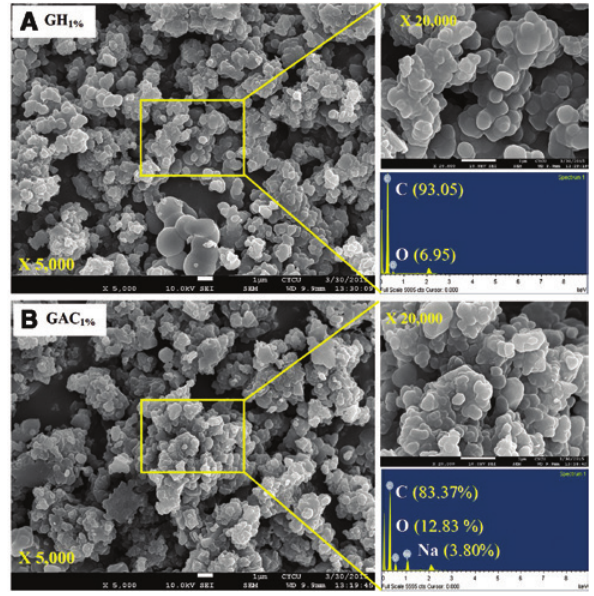
Figure 3: Scanning electron microcopy-energy dispersive X-ray (SEM-EDX) spectra of the (A) glucose-derived hydrochar (GH) (B) glucose-activated carbon (GAC)